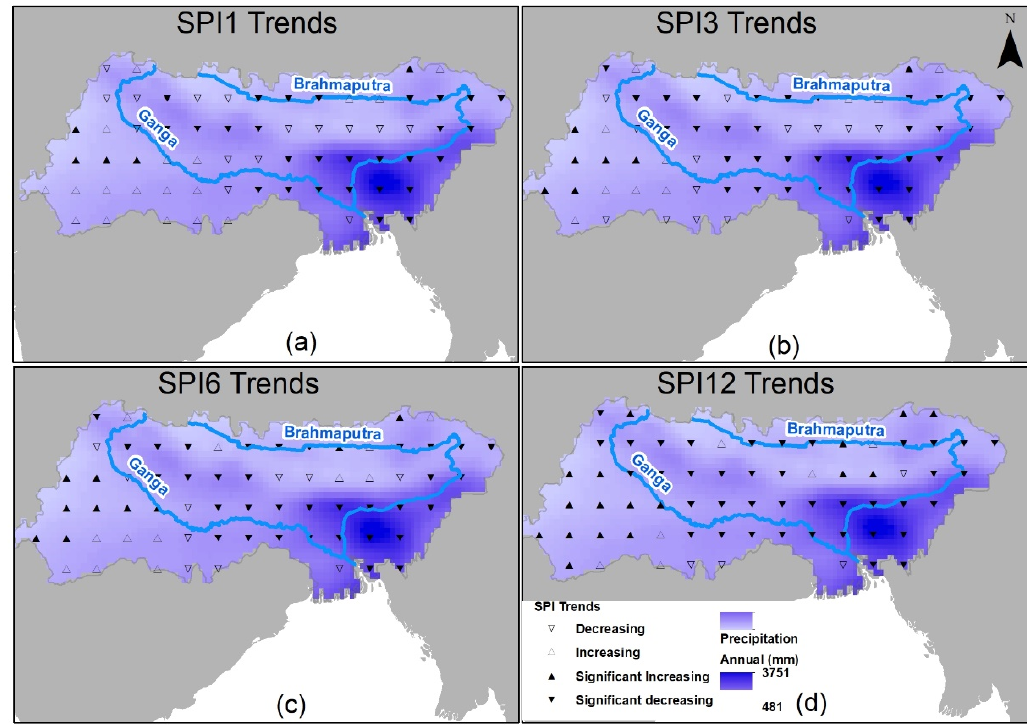
Figure 6. ( a ) Trends of 1 month SPI, ( b ) trends of 3 month SPI, ( c ) trends of 6 month SPI, ( d ) trends of 12 month SPI.